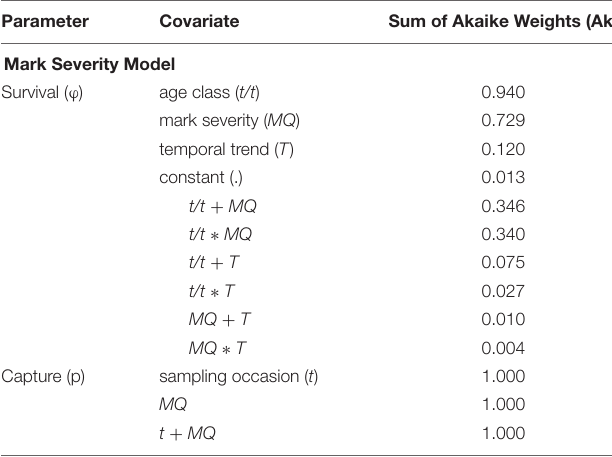
TABLE 5 | Summary of the covariates included in the Mark Severity candidate models, sorted by their respective sum of Akaike weights (Ak) which reflect their relative importance across all candidate